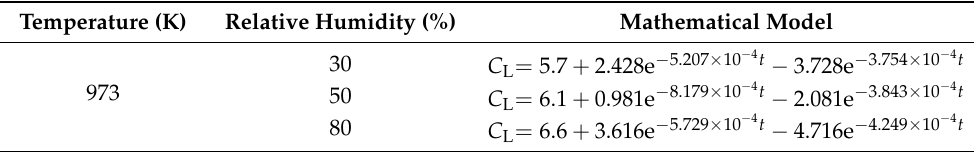
Table 5. Kinetic equation of hydrogen absorption of AA6111 alloy melt under different conditions. Temperature